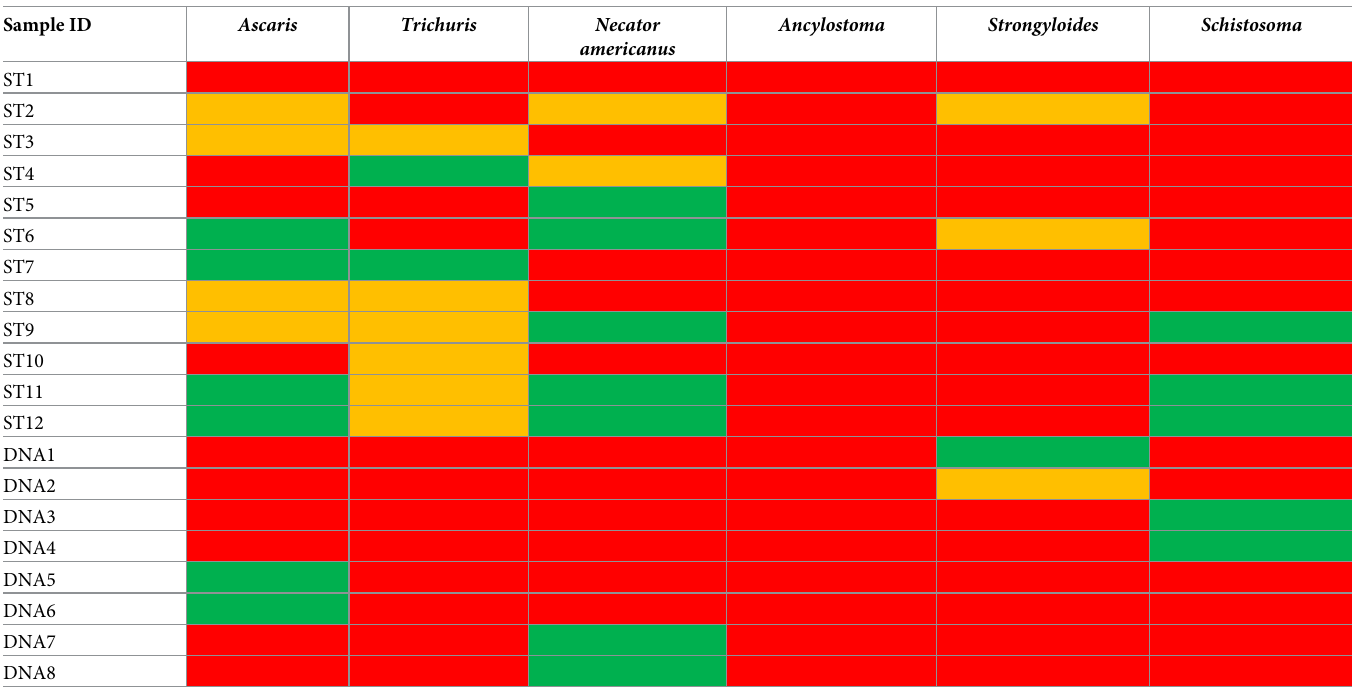
Table 3. Composition of the HEMQAS stool (ST) and the DNA panel. Red cells represent samples that are classified as negative for that particular target; green cells represent samples that are classified as positive for the target; orange cells represent samples that are classified as educational for the target. Sample